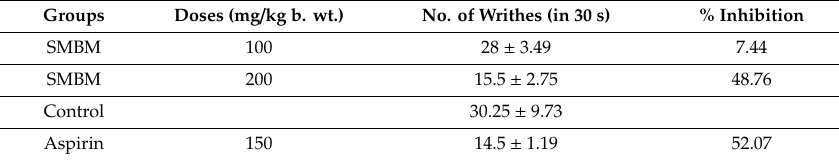
Table 1. SMBM activity in acetic acid-induced writhing test.